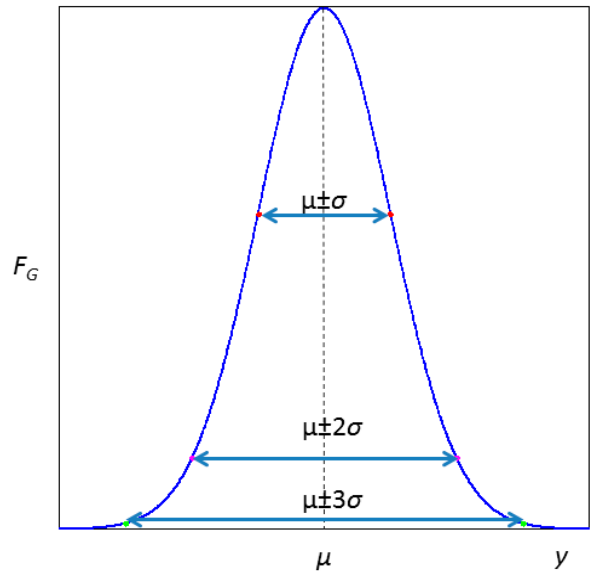
Figure 2. Gaussian Figure 2. Gaussian function.